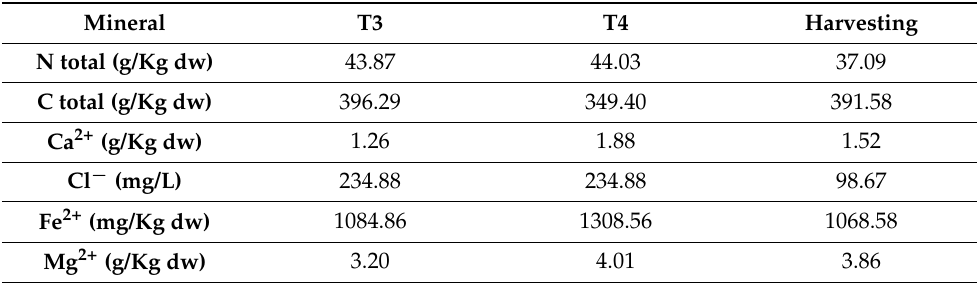
T4 and of the head lettuce at harvesting time.